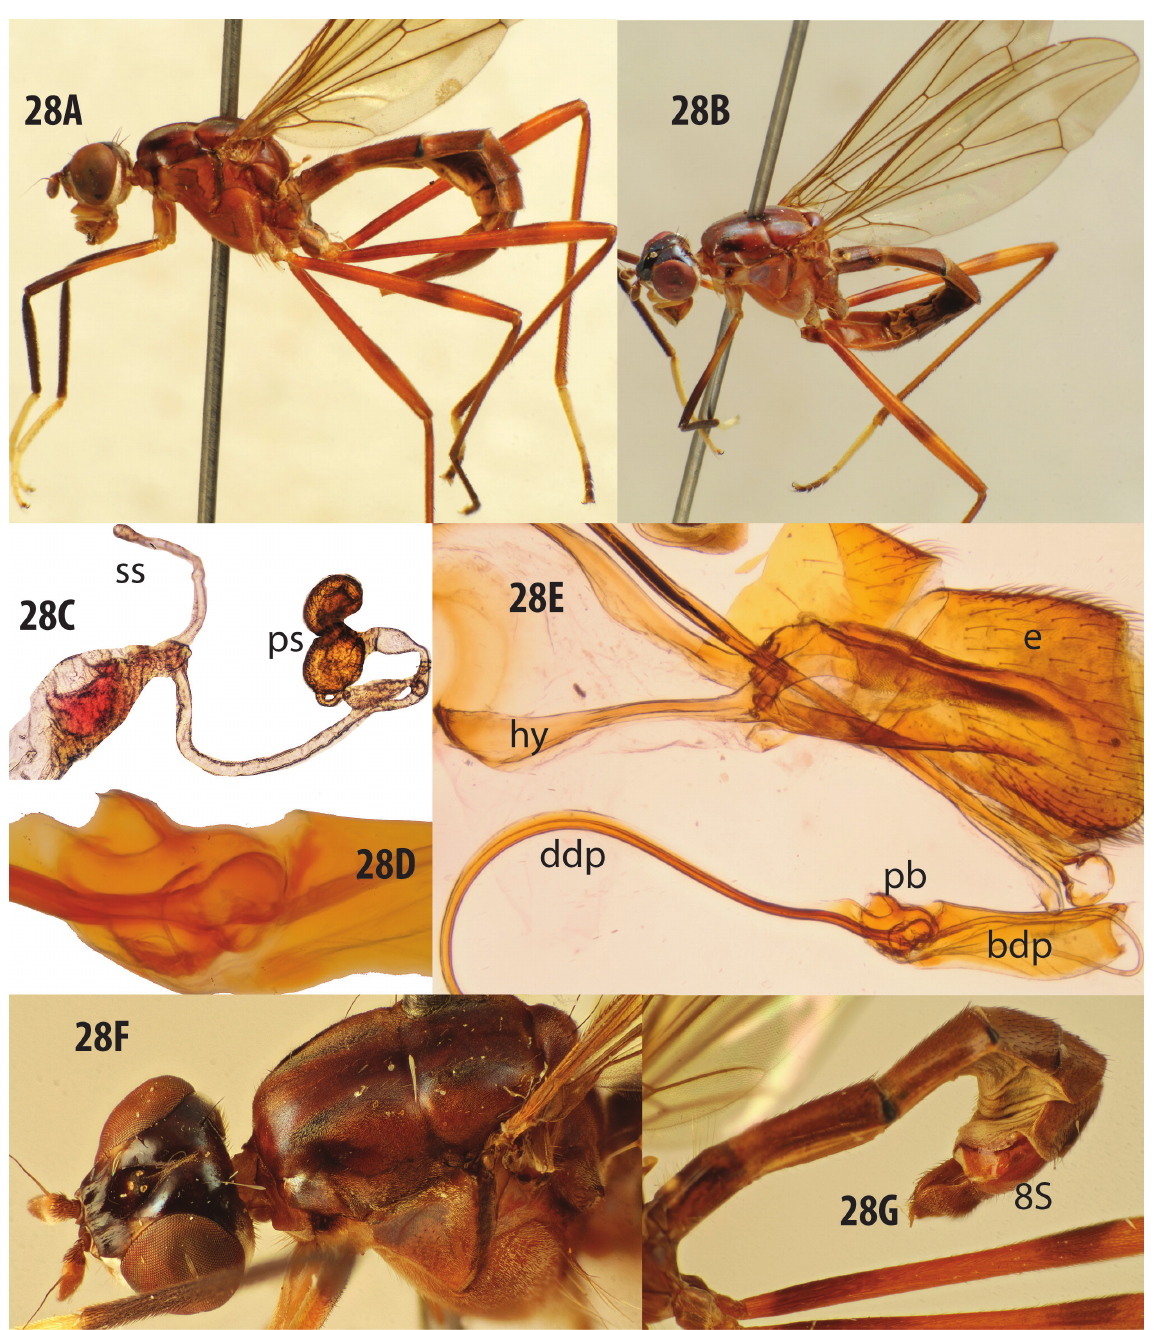
Fig. 28. Mesoconius triunfo sp. nov . A–B . Paratypes, ♀♀, TAUI. C . Spermathecae and associated structures. D . Phallic bulb. E . Male terminalia, left lateral view. F . Head and thorax, ♂. G . Abdomen, ♂. Abbreviations: bdp = basal distiphallus; ddp = distal distiphallus; e = epandrium; hy = hypandrium; pb = phallic bulb; ps = paired spermathecae; ss = single